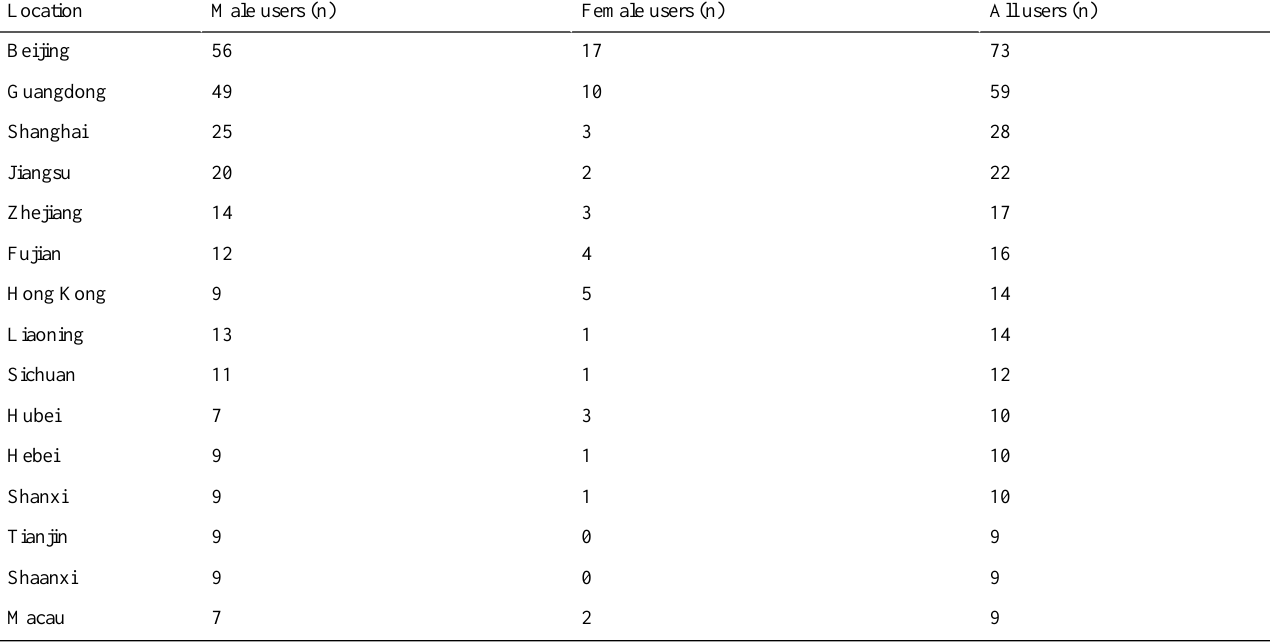
Table 3. Top-ranked locations of the 427 users that provided this attribute